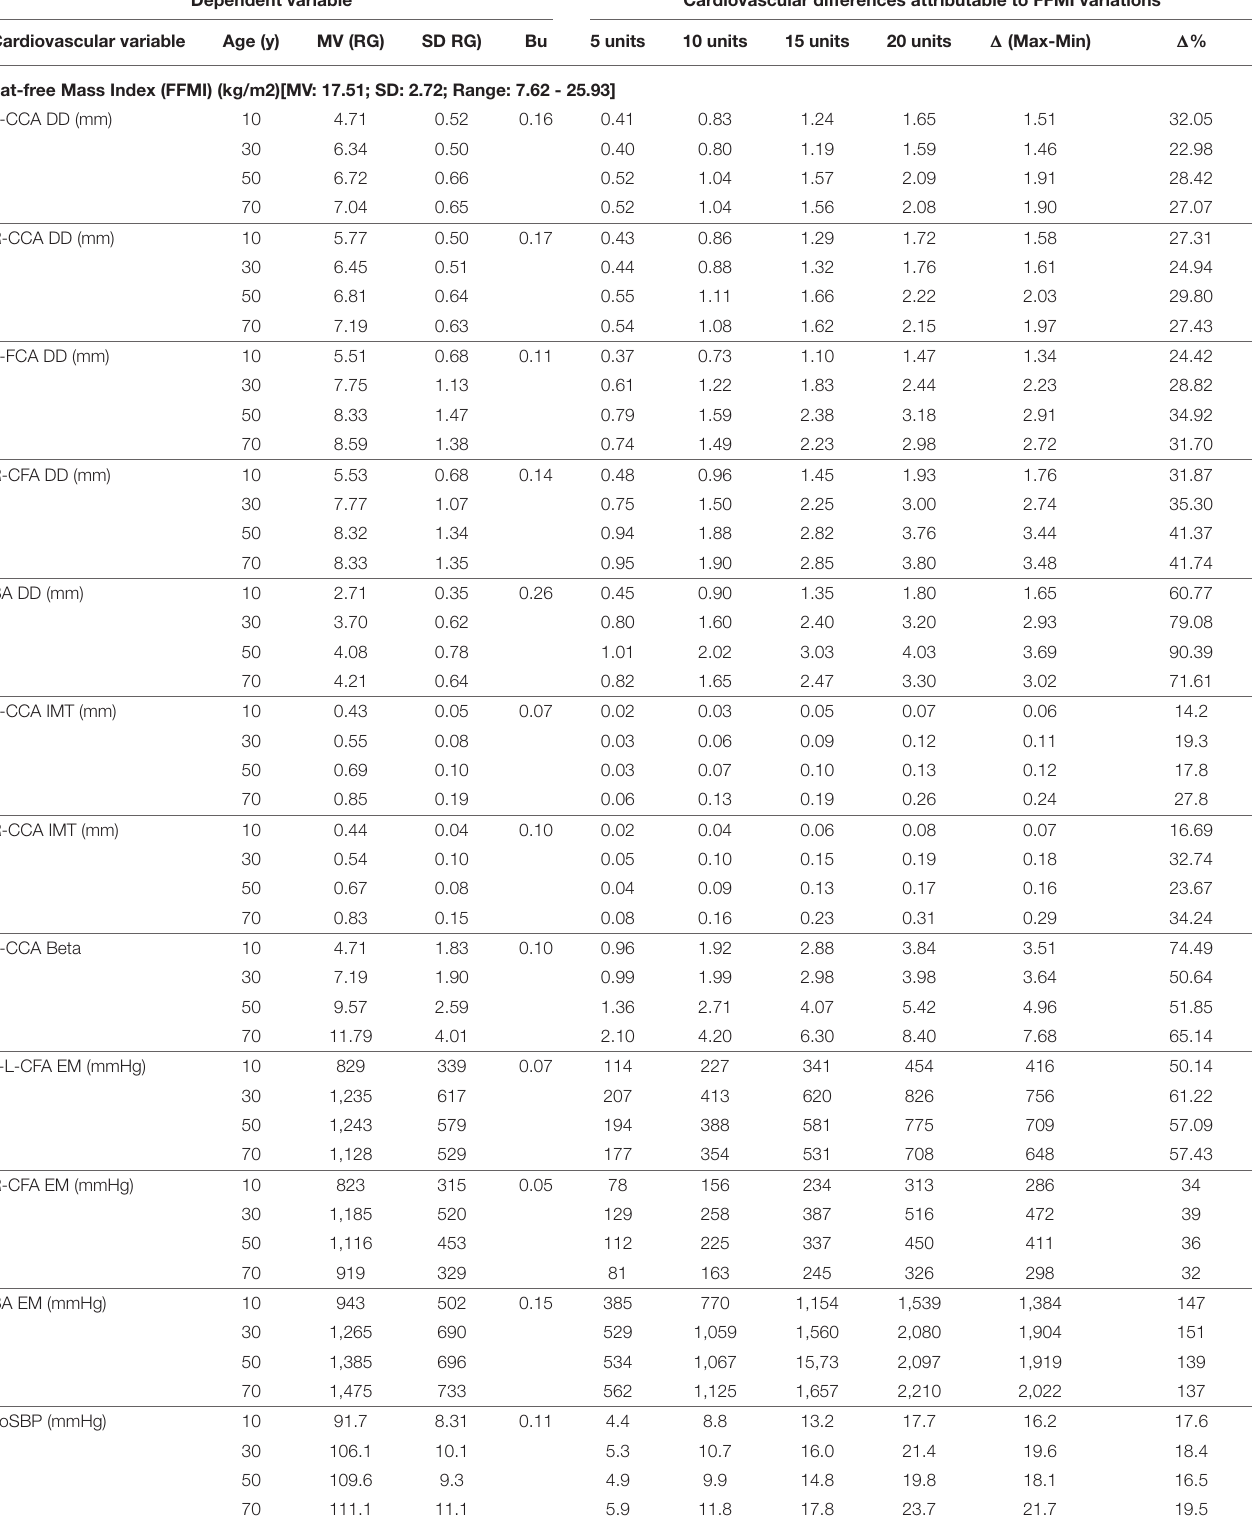
TABLE 3 | Impact of interindividual variations of body composition indices (independent variables) on cardiovascular properties (dependent variables) (OMRON HBF-514C device). Dependent